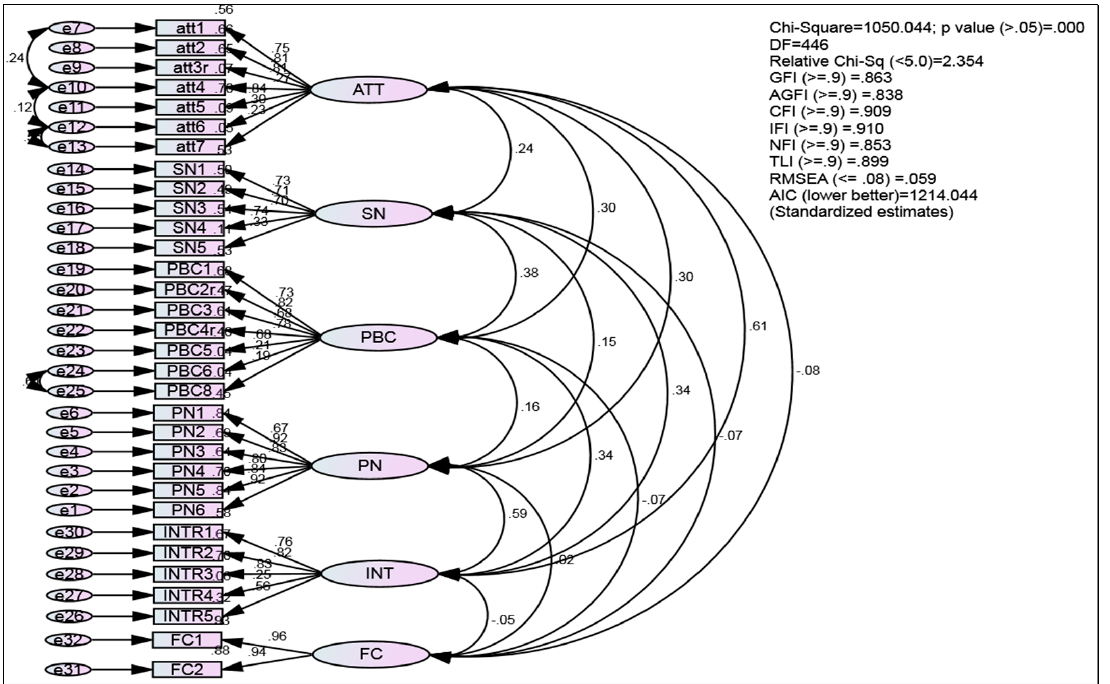
Figure 4. The measurement model of the study. Note: ATT: Attitude (seven items); SN: Subjective norms (five items); PBC: Perceived behavioral control (seven items); PNs: Personal norms (six items); FC: Facilitating conditions (two items); INT: Intention (five items). Table 6. Unstandardized and standardized regression weight in the hypothesized path model 1. Hypothesized Unstandardized Regression standardized Regression S.E CR p Relationship Weight Estimate Weight Estimate 0.593